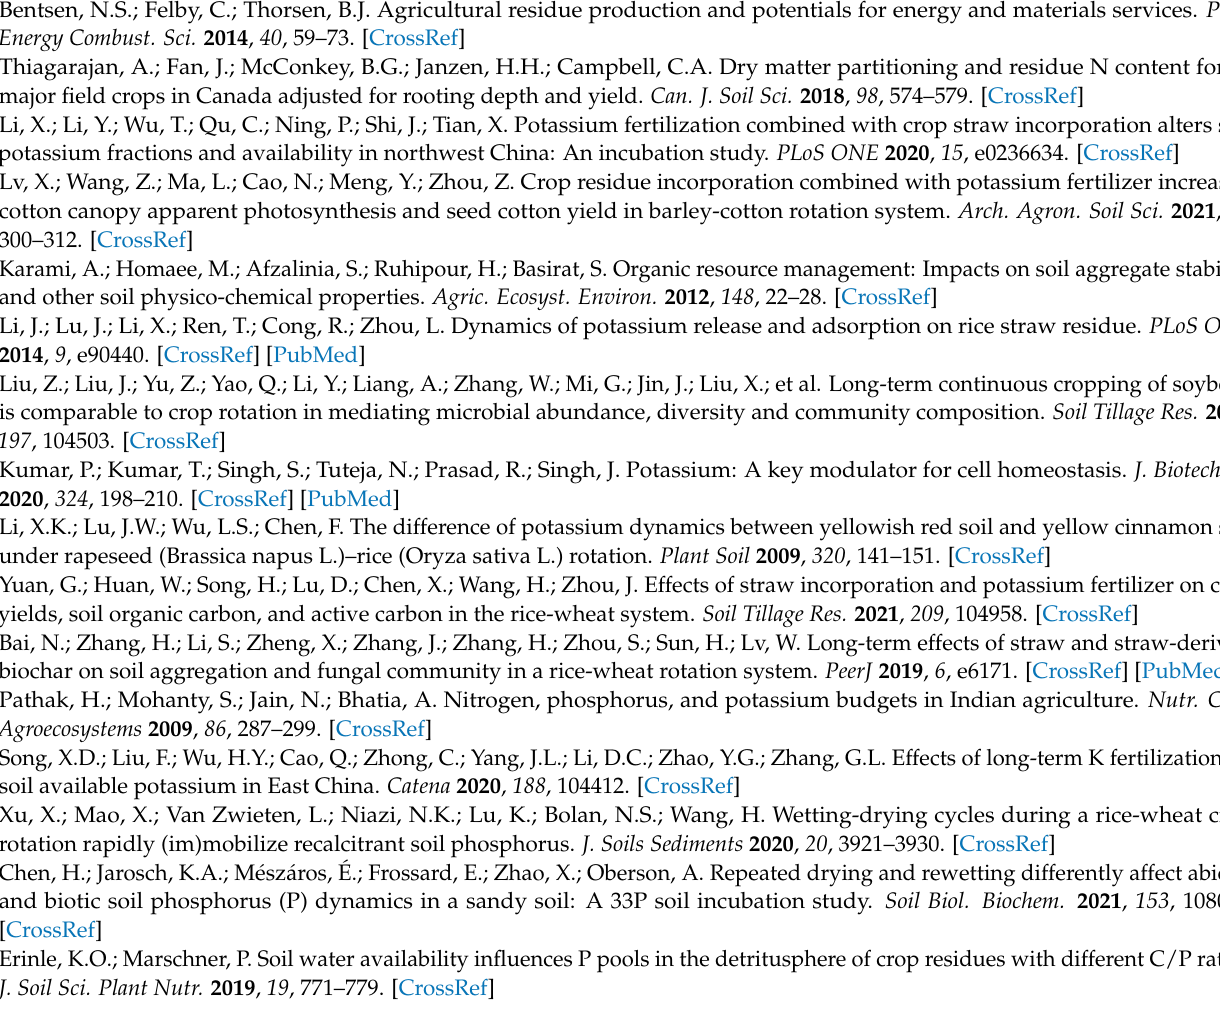
treatments. Table S1: Detailed sequencing depth results of soil samples under different treatments. Table S2: The correction of soil properties with bacterial community structures. Table S3: The correction of soil properties with fungal community